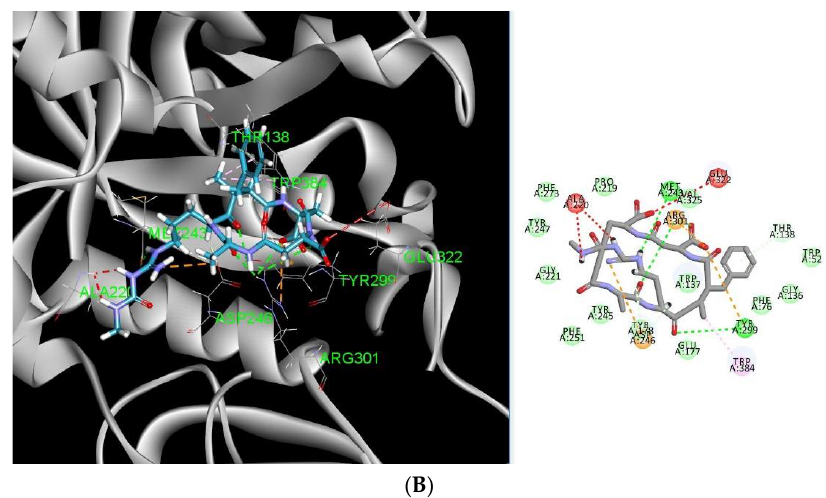
Figure 4. Docking modes of 3cd ( A ) and inhibitor argifin ( B ) with 1W9U.